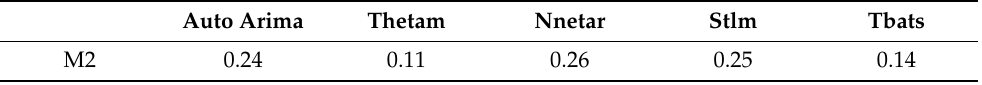
Table 2. The M2 model’s component weights for “depression” score forecasting. Auto Arima Thetam